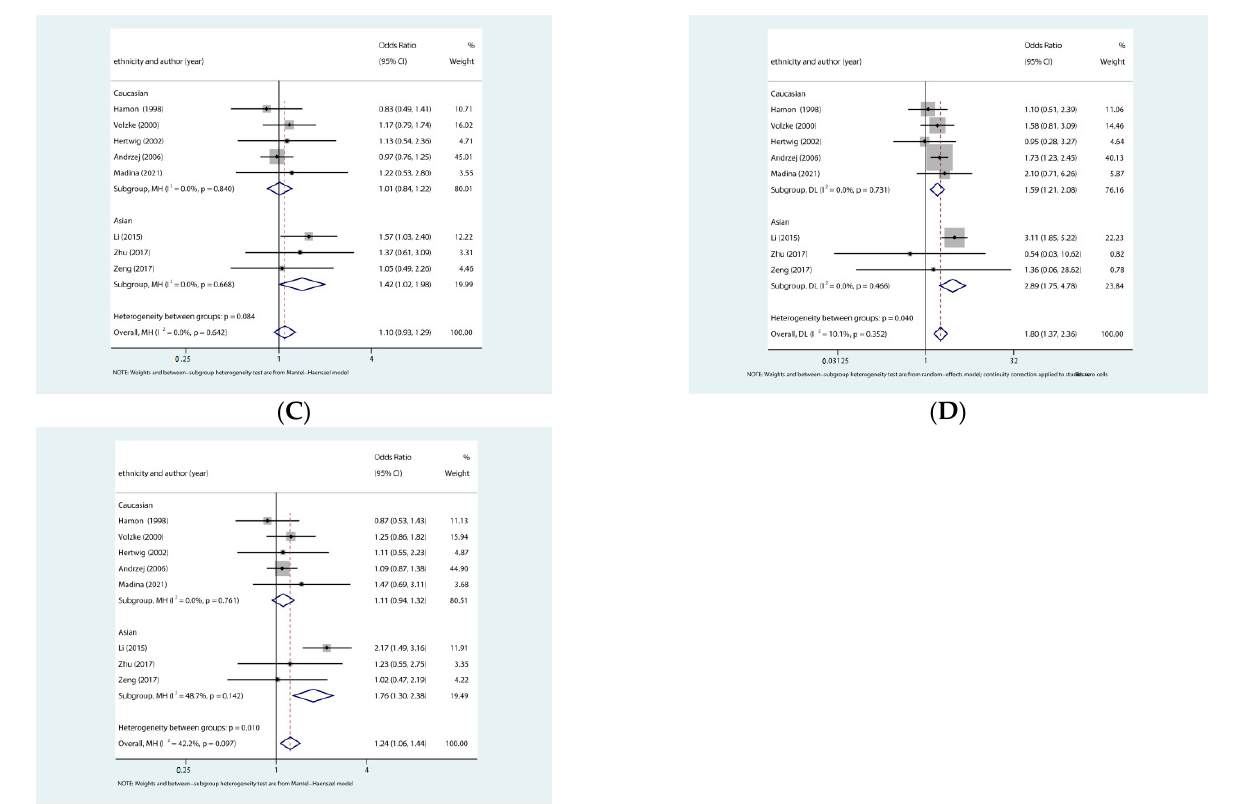
Figure 3. Subgroup meta-analysis by ethnicity of the association of the rs5186 polymorphism and risk of restenosis after PCI. ( A ) allele model: C vs. A; ( B ) homozygote model:CC vs. AA; ( C ) hetero- zygote model: AC vs. AA; ( D ) recessive model: CC vs. AC + AA; and ( E ) dominant model: CC + AC vs. AA. CI = confidence interval, OR = odds ratio [13–20].